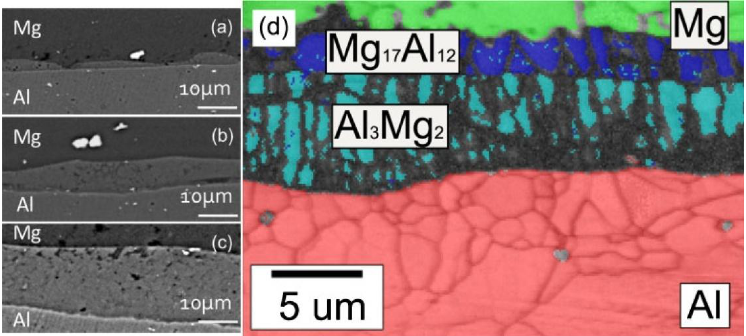
Figure 14. Intermetallic compound layer thickness under different parameters [84].